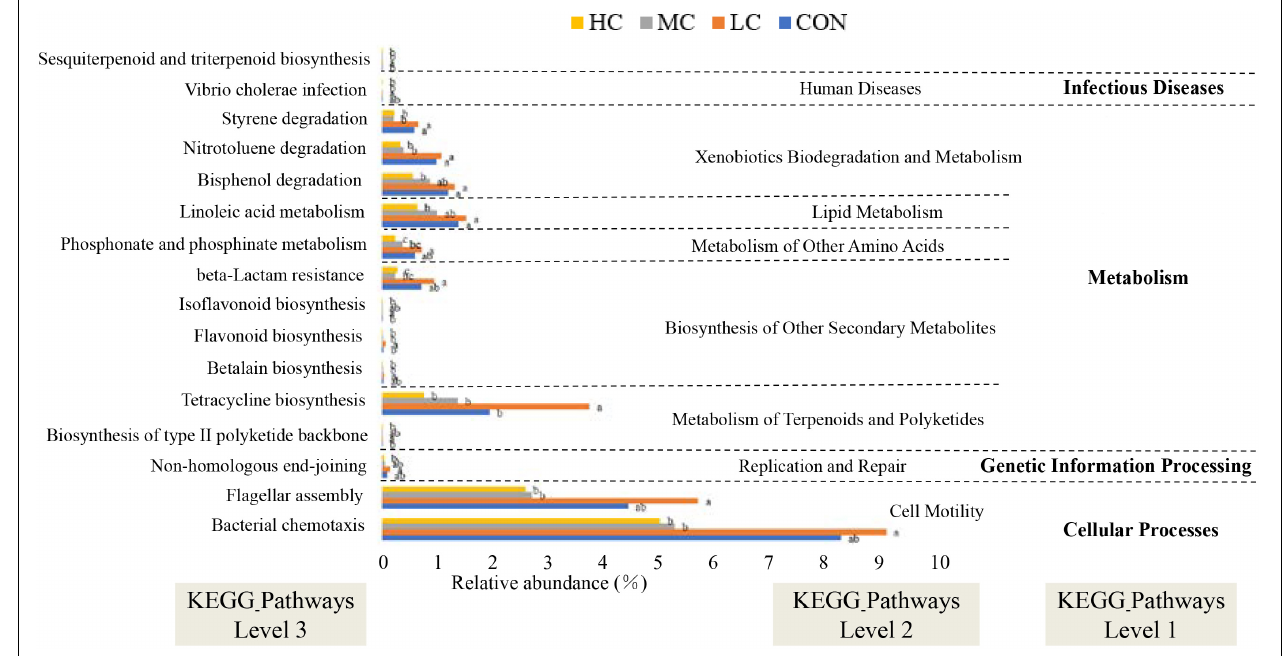
FIGURE 7 | Functional predictions for rumen microbiota with significantly different KEGG pathways ( P < 0.05) for the four add levels (CON, HC, MC, and LC). KEGG pathways at Level 1, Level 2, and Level 3 are represented. CON, C. deserticola at 0%; LC, C. deserticola at 2%; MC, C. deserticola at 4%; HC, C. deserticola at 6%. In each group, different lowercase letters show a significant difference ( P < 0.05), while the same letters show no significant difference ( P > 0.05),